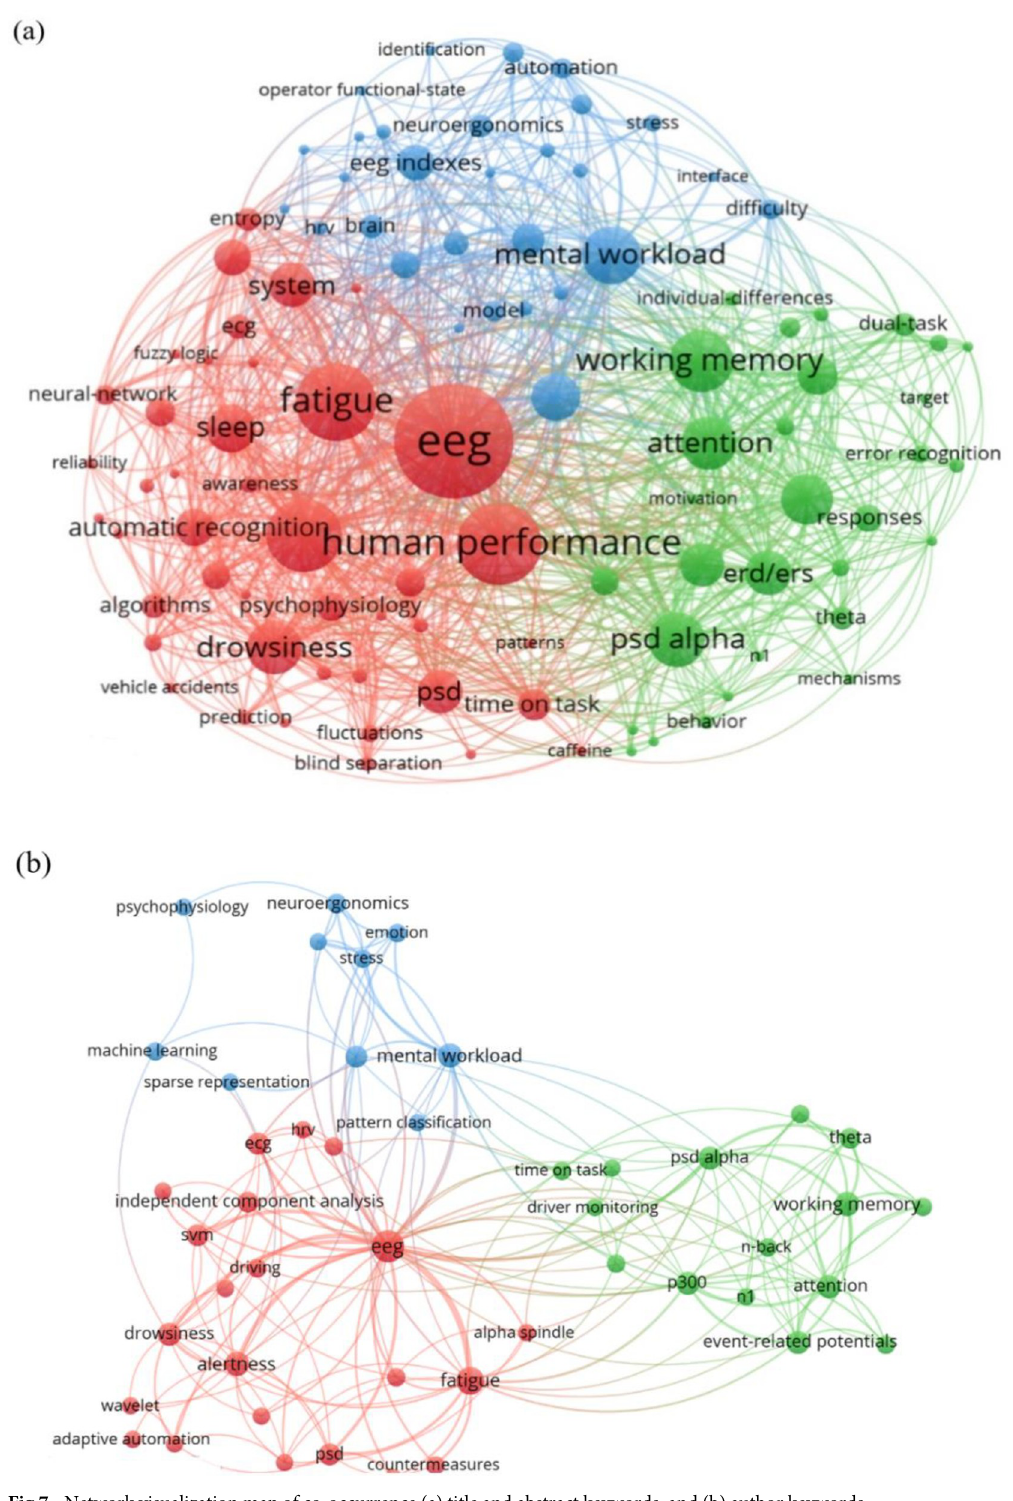
Fig 7. Network visualization map of co-occurrence (a) title and abstract keywords, and (b) author keywords.